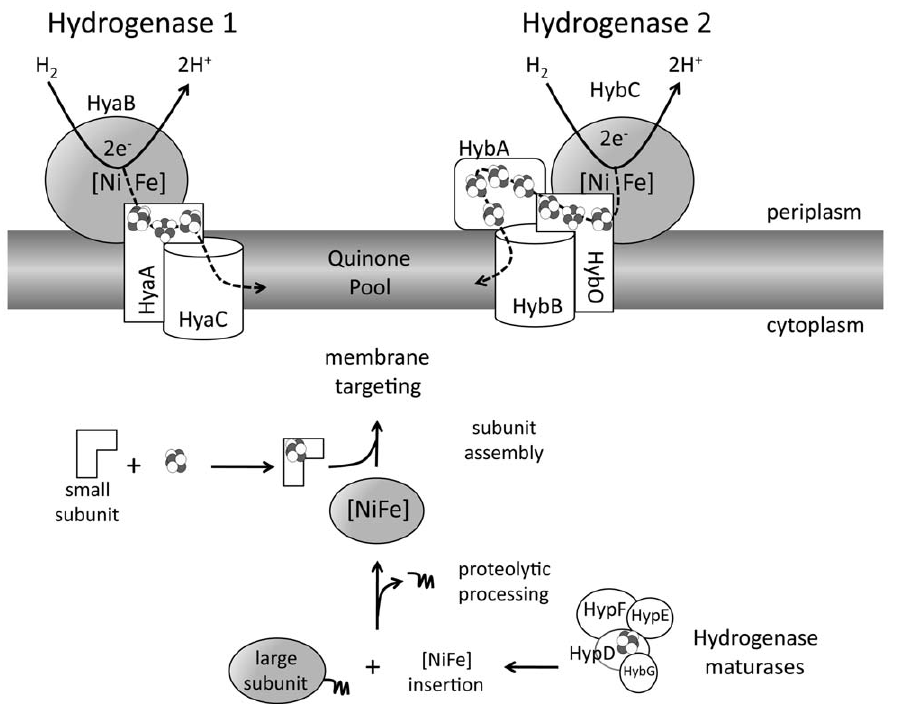
Figure 1. Schematic representation of the iron-sulphur cluster-containing proteins involved in the hydrogen oxidation of E.coli . The two anaerobic, membrane-associated [NiFe]-hydrogenases 1 and 2 are schematically represented with their associated subunits. The iron-sulphur clusters are shown as groups of spheres. No distinction is made between [3Fe-4S], [4Fe-4S] or [4Fe-3S] clusters. The ’squiggle’ attached to the apoprotein form of the hydrogenase catalytic subunit (bottom of the Figure) represents the C-terminal peptide that is removed subsequent to insertion of the [NiFe] cofactor. The dotted arrows indicate electron flow within the modular enzymes or to the quinone pool.